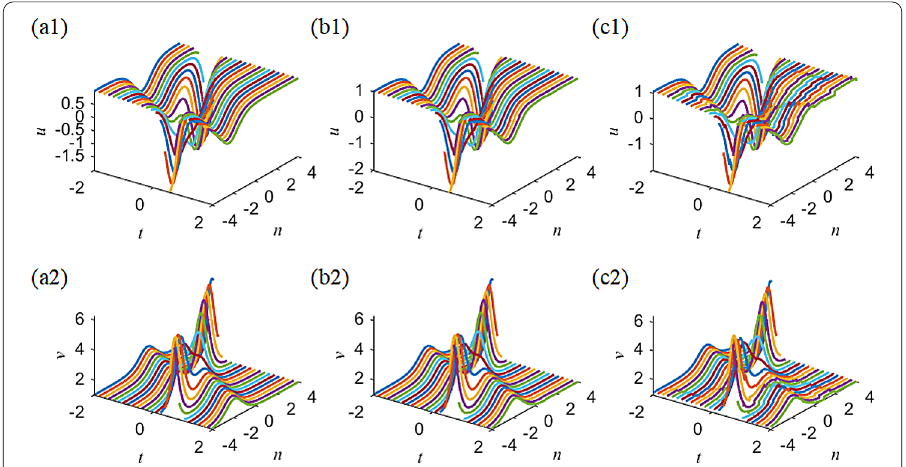
Figure 6 Two-soliton solution (43) with the same parameters as Fig. 1. ( a ) Exact solution; ( b ) Time evolution using exact solution (43) as an initial condition; ( c ) Time evolution using exact solution (43) perturbed by a 5%